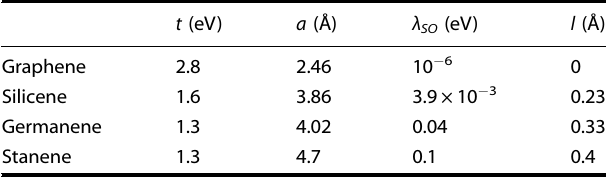
Table 1. The parameters corresponding to various monolayer 2D-